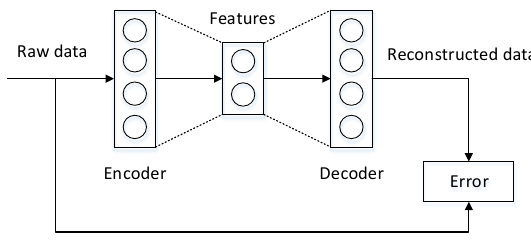
Figure 3. The structure of an autoencoder.